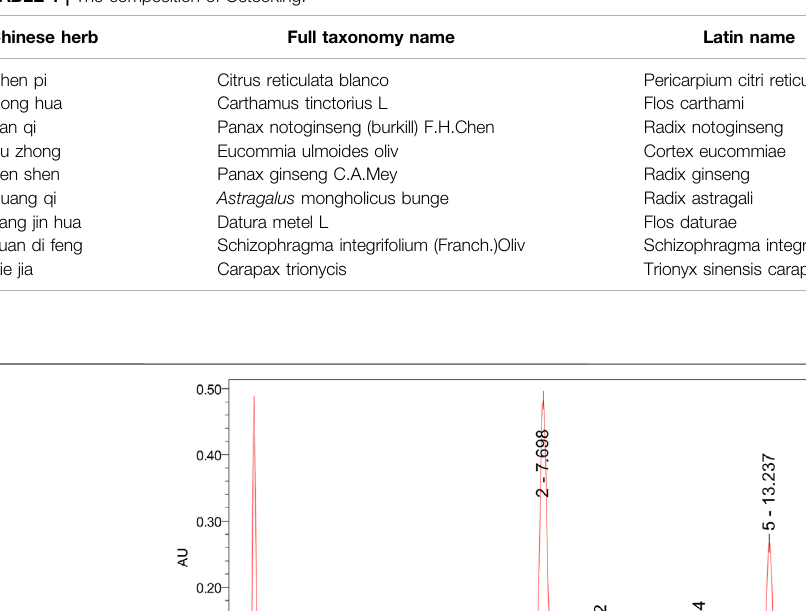
TABLE 1 | The composition of Osteoking.